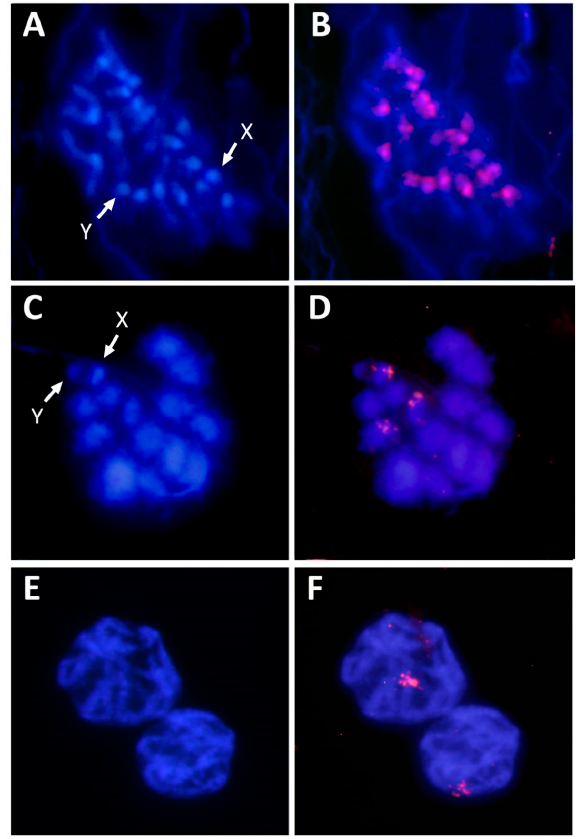
Figure 5. Chromosome location of the most abundant satDNAs of Hippodamia variegata . Mitotic metaphase stained with DAPI ( A ) and FISH with the HvarSat01-277 probe ( B ). Meiosis I stained with DAPI ( C ) and FISH with the HvarSat02-127 probe ( D ). Meiotic paquitenes stained with DAPI ( E ) and FISH with the HvarSat03-217 probe ( F ).